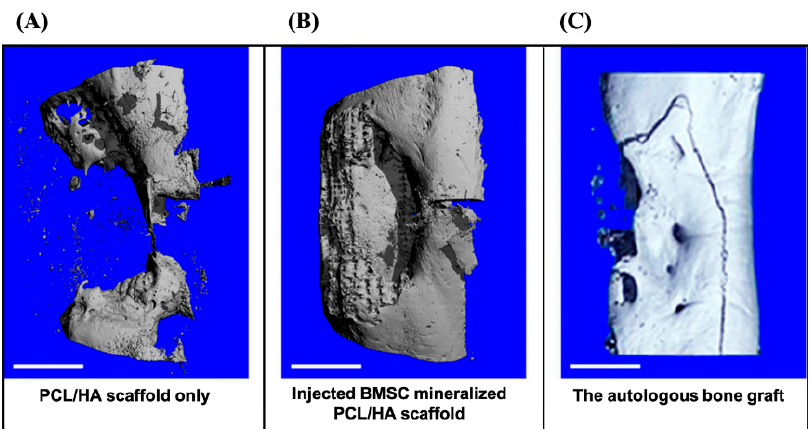
Figure 5. The micro-CT analysis after 3D reconstructions. ( A ) The tibia bone defect was repaired with PCL/HA scaffold only. ( B ) The BMSC cell sheet was injected into the PCL/HA scaffold for in situ mineralization. ( C ) The autologous bone graft (ABG) positive control. Scale bars: 1 cm. Adapted with permission from [78].